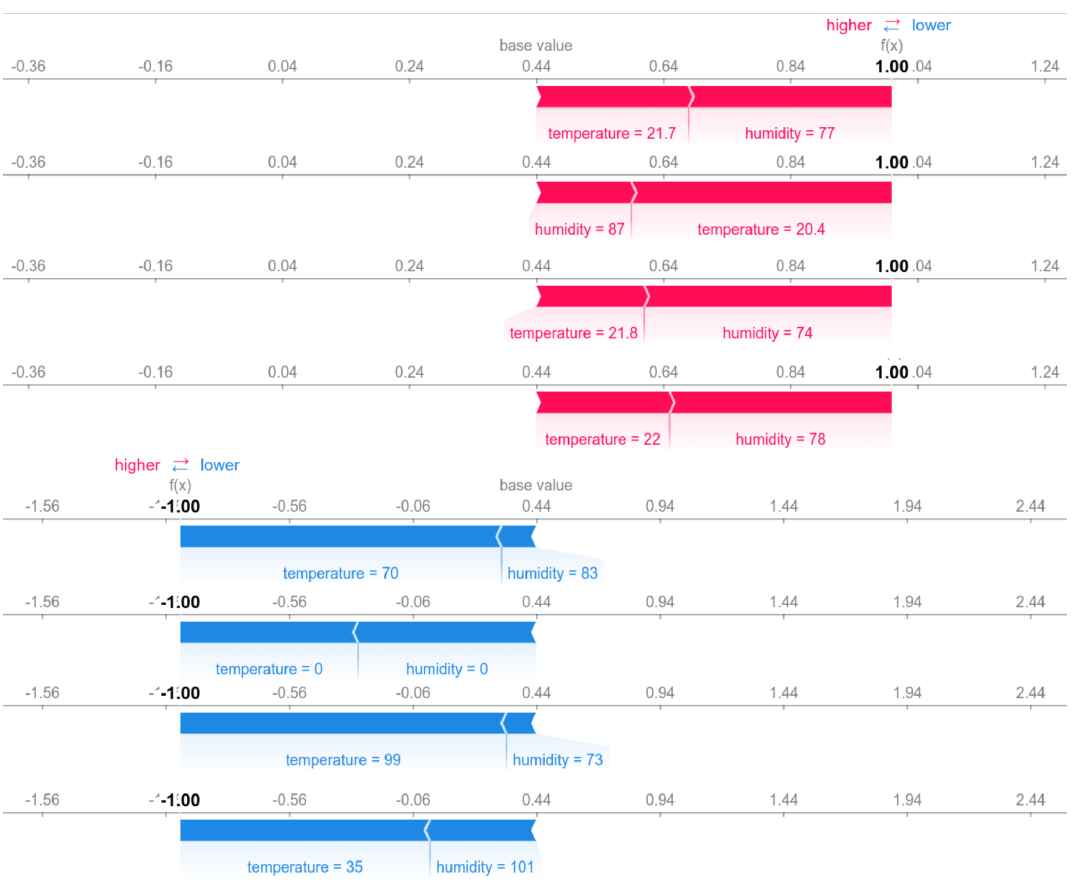
Figure 31. Classifications and their respective impact in the model